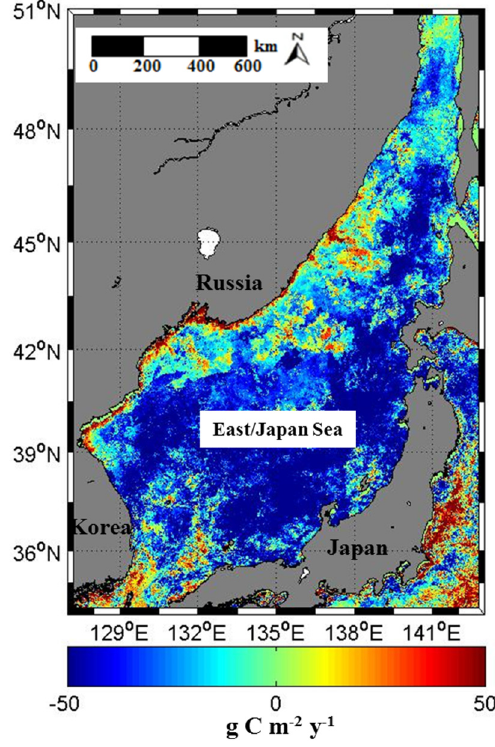
Figure 9. Spatial distribution of annual production difference between 2003 and 2012 in the East Sea.